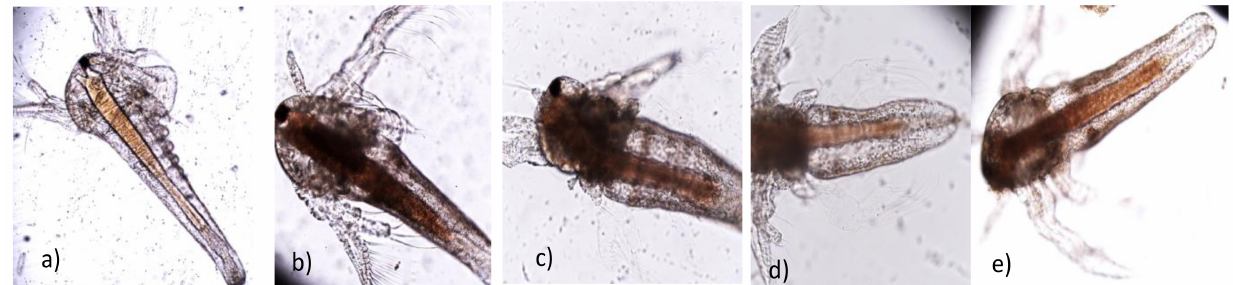
Figure 5. Microscopic details of exposed larvae—( a ) negative control; ( b ) UBDE in water; ( c ) UBDE in methanol; ( d ) UBDE in ethyl acetate; ( e ) UBDE in acetone (magnification ×